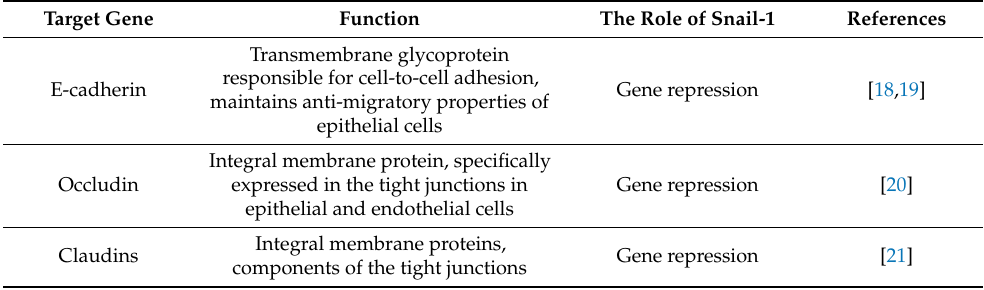
Table 1. Examples of the most important target genes that are associated with carcinogenesis regulated by Snail-1